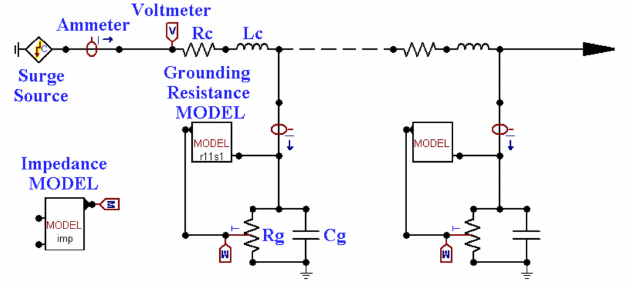
Figure 4. Example of ATP model for vertical